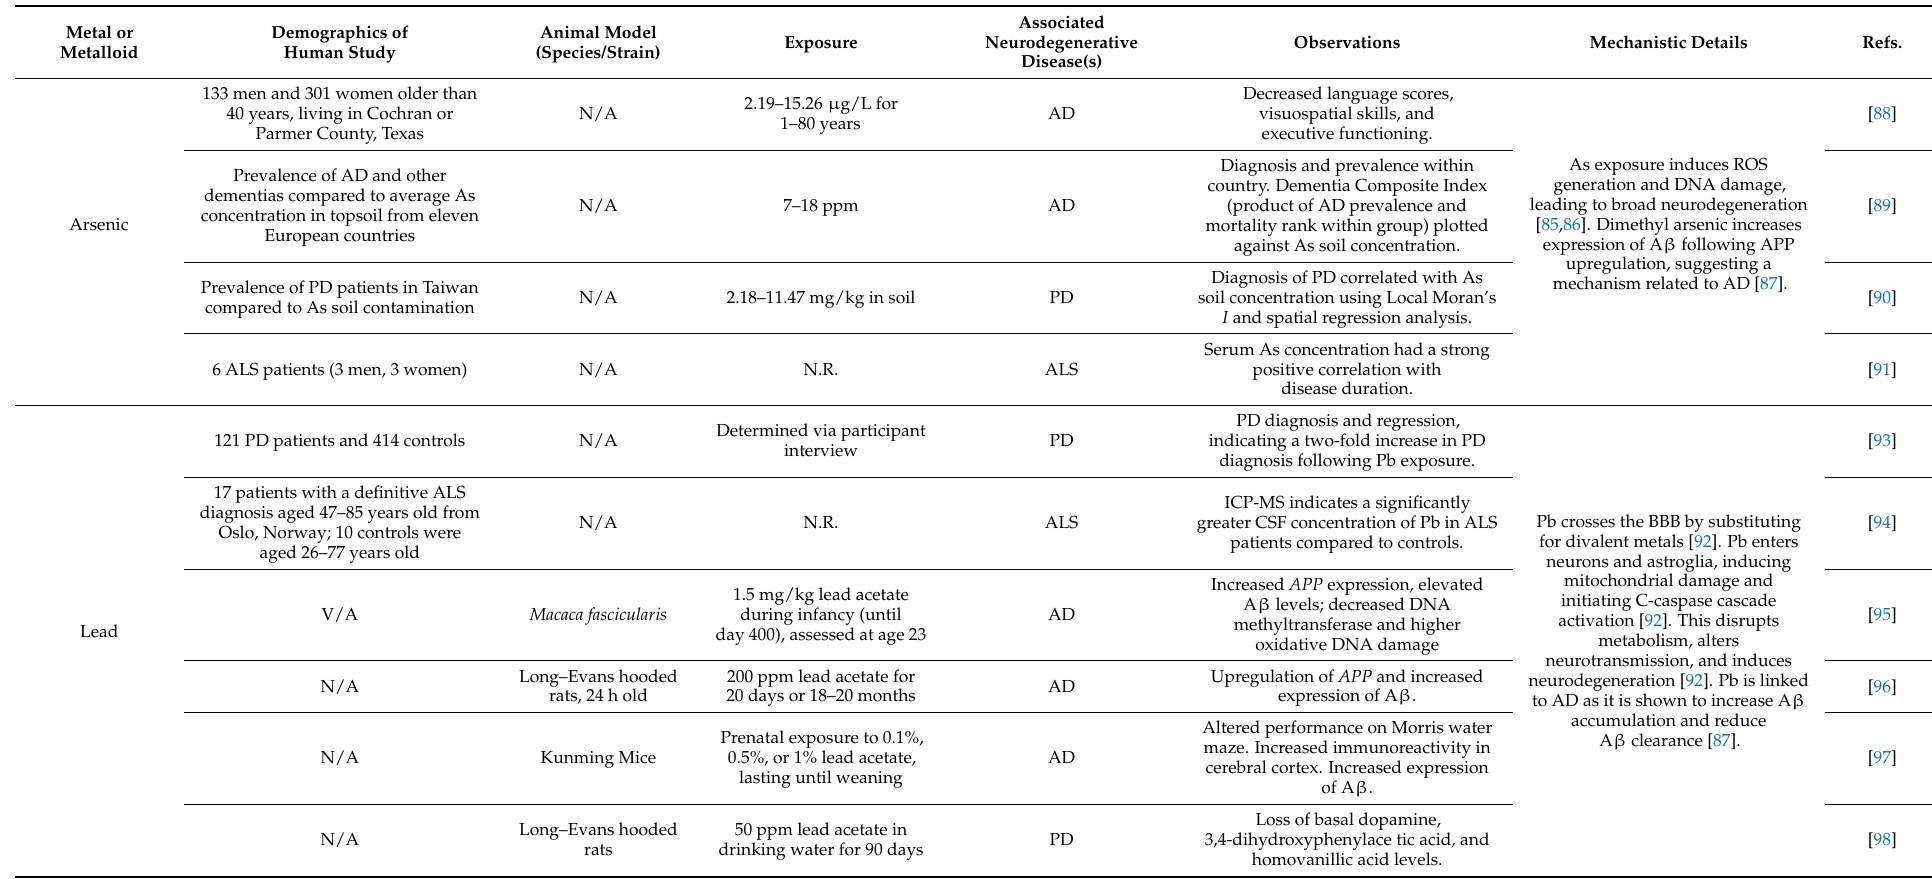
Table 1. Associations between heavy metals/metalloids and neurodegenerative